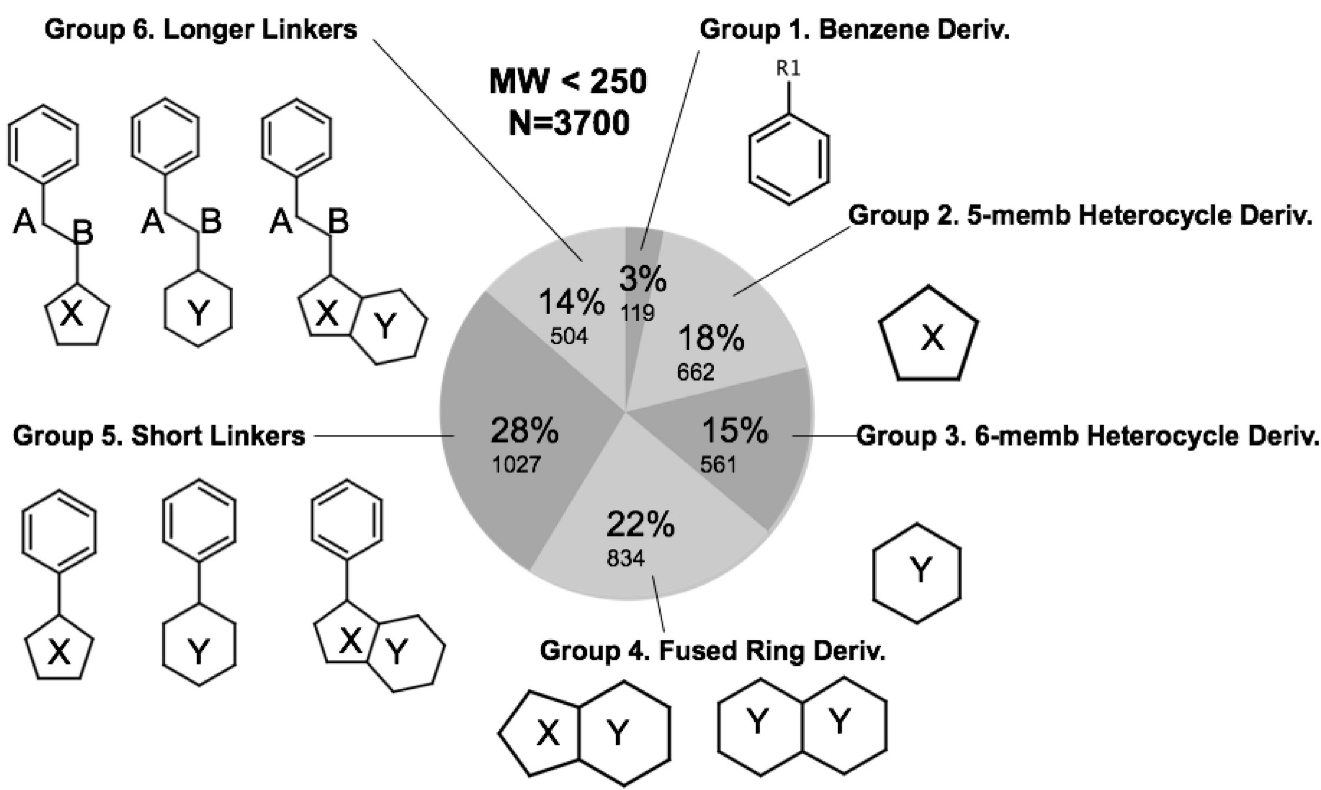
Fig 3. Aromatic heterocycle fragment replacement library. Additional details in supplementary information.